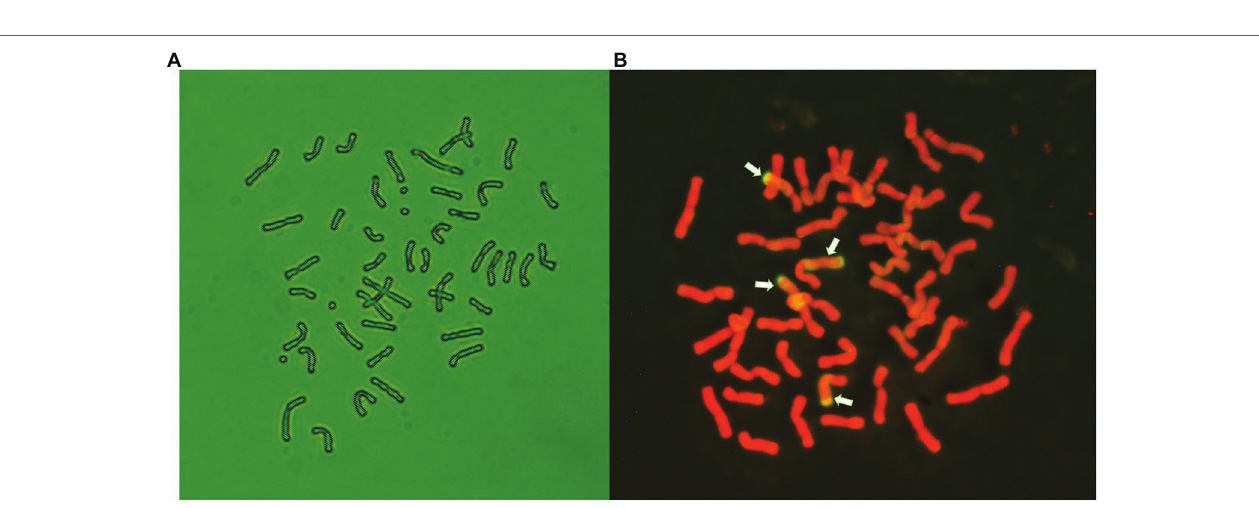
FIGURE 2 | Cytological and genomic in situ hybridization (GISH) analysis of line E24-3-1-6-2-1. (A) Mitotic metaphase, 2 n = 44. (B) GISH analysis of the chromosome constitution of E24-3-1-6-2-1. GISH was conducted using Psathyrostachy shuashanica DNA as a probe and Chinese Spring DNA as a blocker. Four chromosomes with fluorescent hybridization signals (yellow-green) were identified as having alien segments in E24-3-1-6-2-1. The chromosomes were counterstained with propidium iodide (PI;